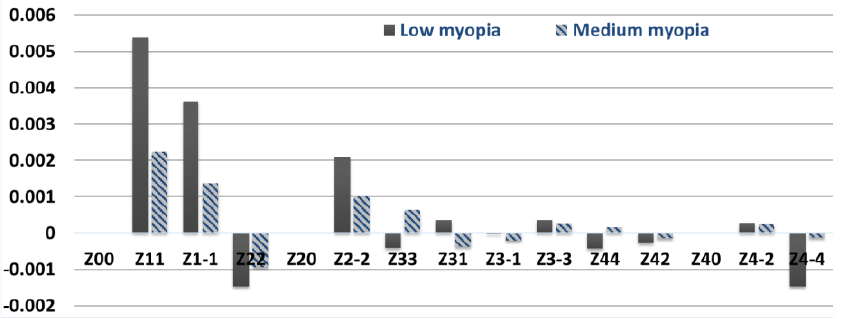
Figure 3. The values of the coefficients that must be subtracted from the anterior surface of the cor- nea for diagnoses of low and medium myopia (through the view).